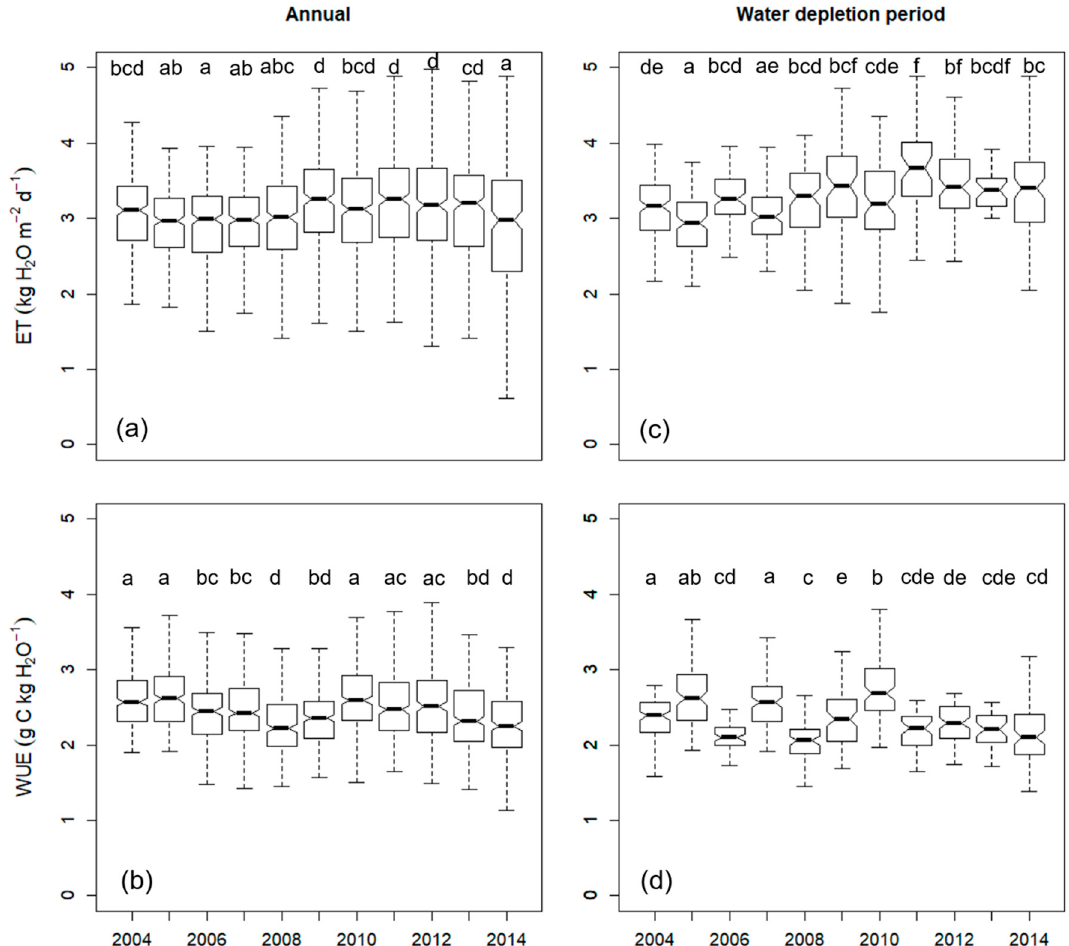
Figure 2. Interannual variations in ecosystem evapotranspiration (ET) ( a ) and ( c ) and water use efficiency (WUE) ( b ) and ( d ) at the whole year scale (left) and during water depletion (WD) periods (right). Daily data from 2004 to 2014 were used. In the boxplots, the thick line shows the median; the box extends to the upper and lower quartiles; and dashed lines indicate the nominal range. For a given graph, different letters denote significant differences among years ( p < 0.05).